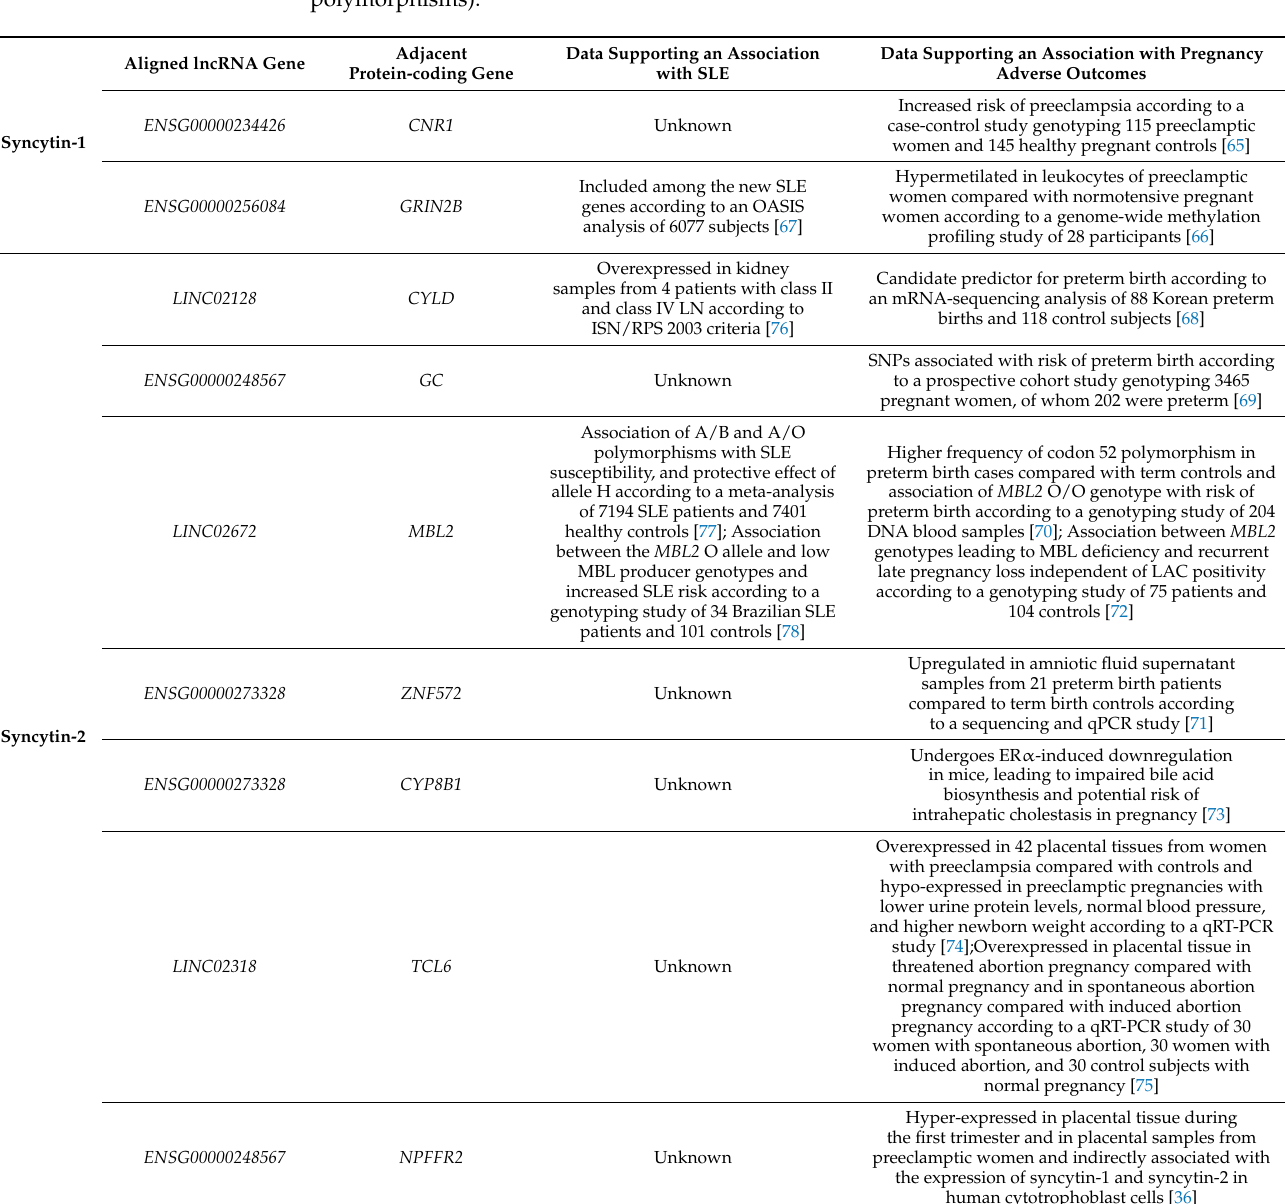
Table 6. Results of studies reporting associations between protein-coding genes adjacent to lncRNA genes with hits in the syncytin-1 and syncytin-2 nucleotide sequence and SLE or pregnancy adverse outcomes (ER α : estrogen receptor α ; GWAS: genome-wide association study; ISN/RPS: International Society of Nephrology/Renal Pathology Society; LN: lupus nephritis; qPCR: quantitative polymerase chain reaction; qRT-PCR: quantitative real time-polymerase chain reaction; SNPs: single nucleotide